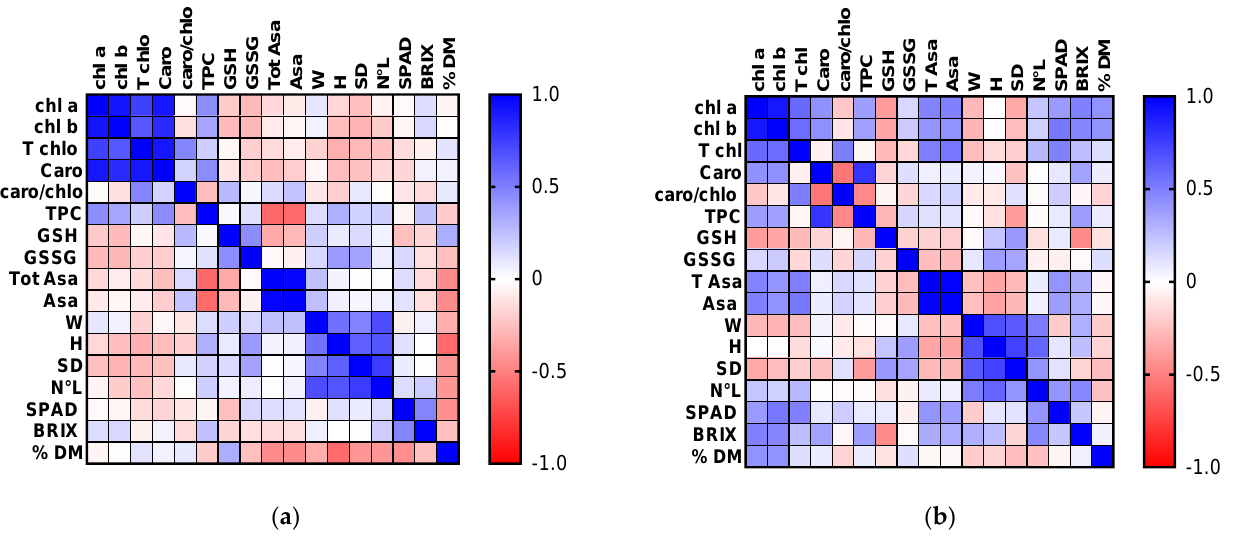
Figure 4. Heat maps of Pearson’s correlation between morphological and biochemical traits in ( a ) control conditions; ( b ) drought conditions; Chla: chlorophyll a; Chl b: chlorophyll b; TChl: total chlorophyll (a + b); Caro: carotenoids; TPC: Total phenolic compounds; GSH: Reduced glutathione; GSSH: oxidized glutathione; AsA: ascorbic acid; Tot AsA: DHA + AsA; W: plant weight; H: plant height; SD: stem diameter; N°L: number of leaves; % DM: dry matter; SSC: Soluble Solids Content (° BRIX).